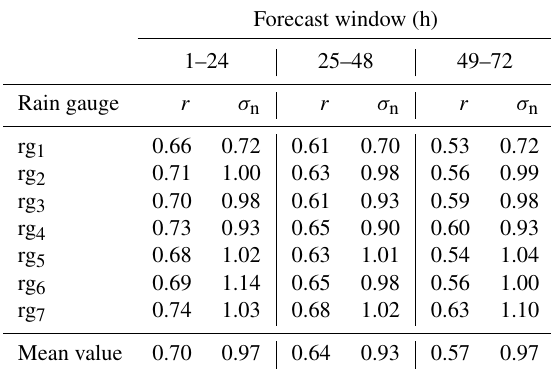
Table 2. Values of the correlation (Spearman’s r ) and normalised standard deviation ( σ n ) of the precipitation forecast using the mea- sured data as reference at each rain gauge, considering the complete time series of precipitation. The averaged values for each precipita- tion forecast are also shown.